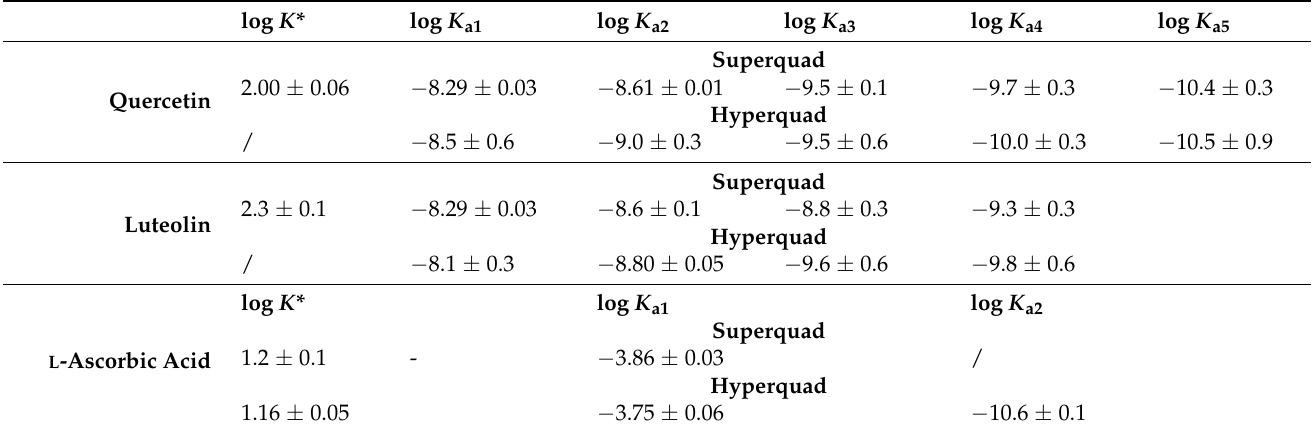
Table 1. Survey of the log K * and log K m values, according to general equilibria 3 and 4, by numerical methods. The uncertainties represent 3 σ